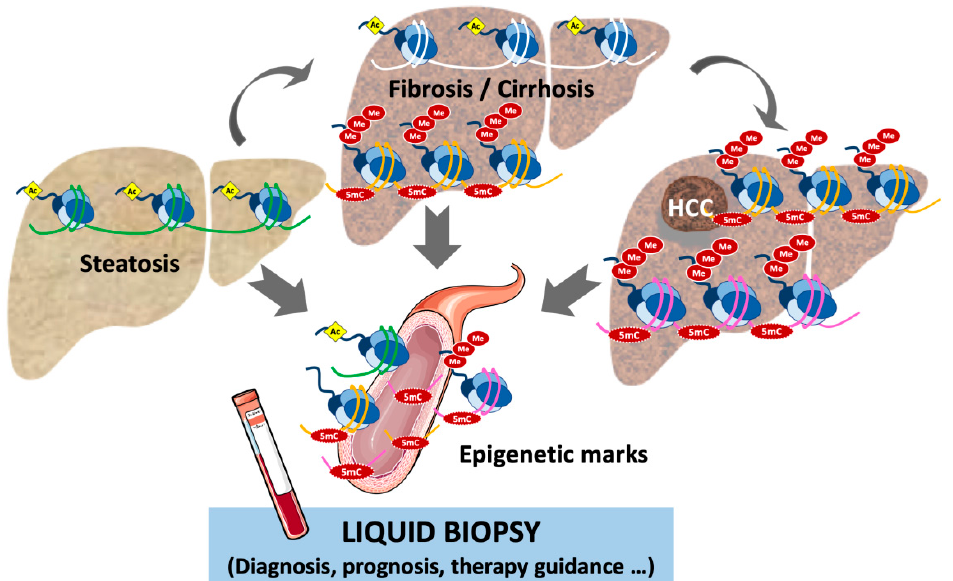
Figure 2. The epigenetically marked DNA and chromatin are released from the damaged liver to the bloodstream. Therefore, the identification of disease-specific epigenetic biomarkers in the plasma or liquid biopsy represents a non-invasive tool for the early detection of fibrosis or diagnosis of HCC and the prognosis and therapeutic guidance of patients.